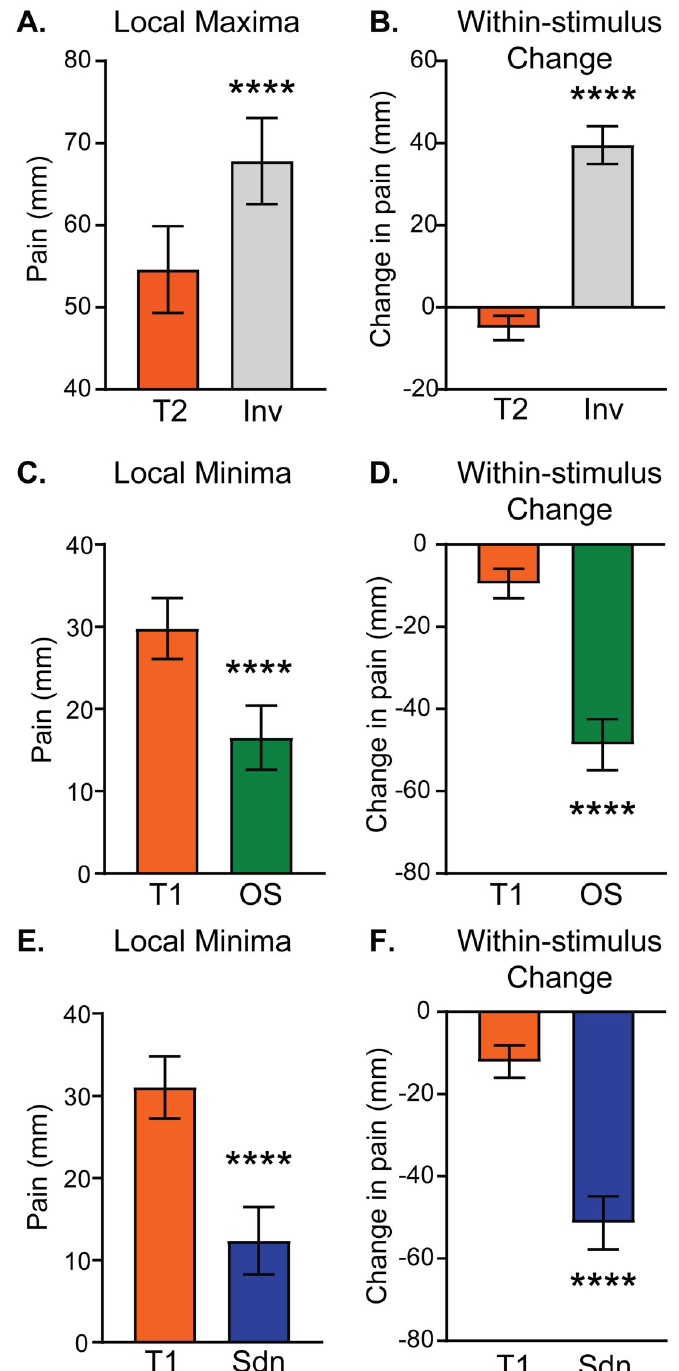
Fig 3. Extrema in continuously-rated pain intensity during stepped stimuli are significantly different than constant control stimuli. Pain intensity values on the computerized visual analogue scale were extracted at local maxima (A & B) and minima (C-F) for each subject as described in Fig 1. Pain intensities at matching timepoints were also extracted during constant control stimuli (T1 or T2). In the left column, pain intensities are compared between stepped and control stimuli (arrow “a” in Fig 1). In the right column, the change in pain intensity within the stepped curve is compared with the change in the control curve during the same time interval (arrow “b” in Fig 1). Group means with 95% CI are depicted in the bar graphs. Paired t-tests showed significant differences: ���� p < 0.0001.